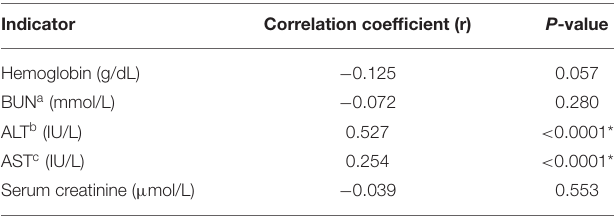
TABLE 5 | The correlation between serum ferritin levels and all the hematological and biochemical parameters of patients with β -thalassemia. Indicator Correlation coefficient (r) P -value Hemoglobin (g/dL) − 0.125 0.057 BUN a (mmol/L) − 0.072 0.280 ALT b (IU/L) 0.527 < 0.0001* AST c (IU/L) 0.254 < 0.0001* −